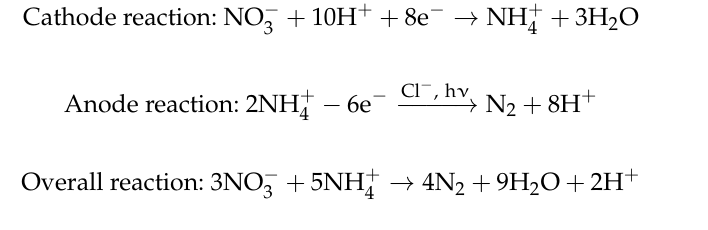
Figure 3. Schematic diagram of NH − NO − fuel cell mechanism integrated with nitrification 3 3 3